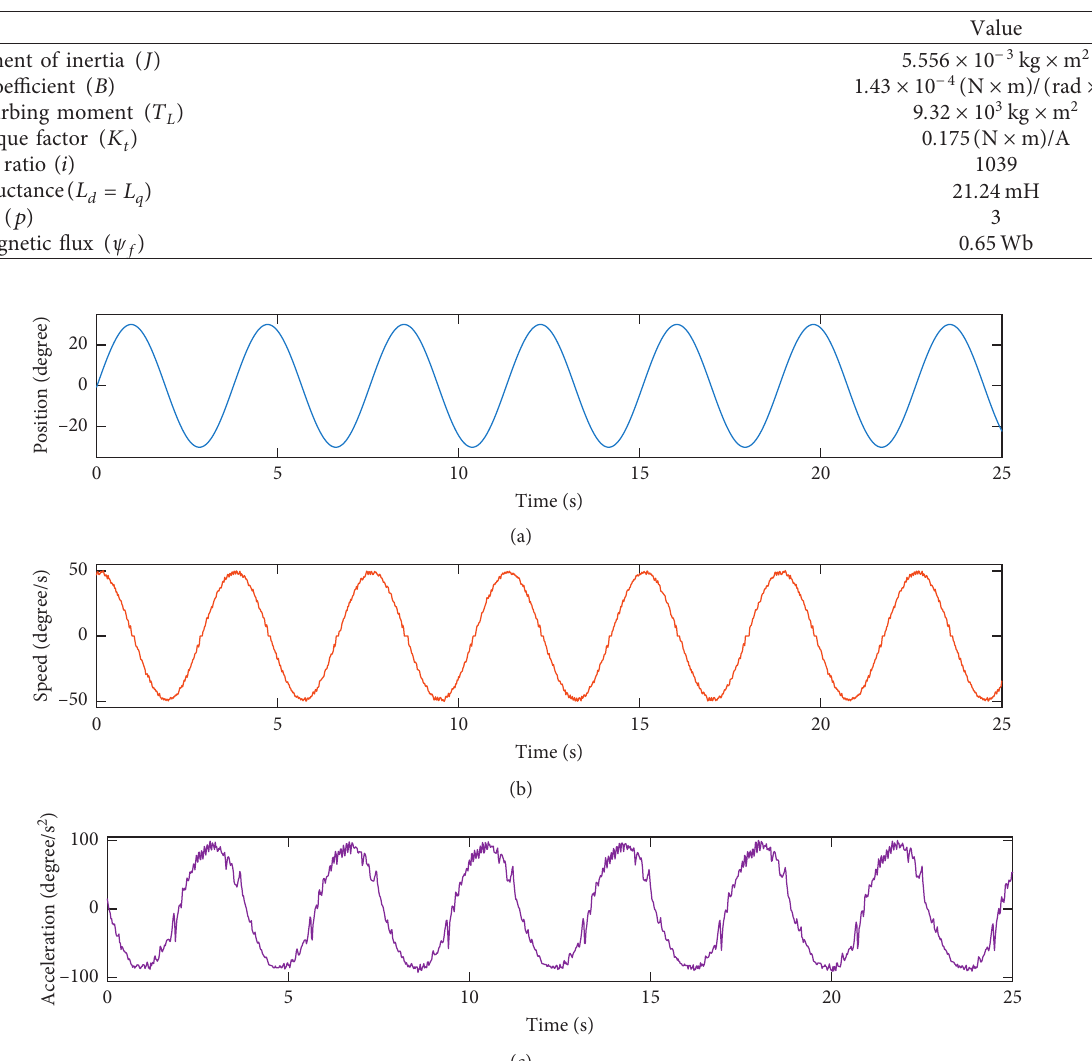
Figure 12: Sinusoidal tracking